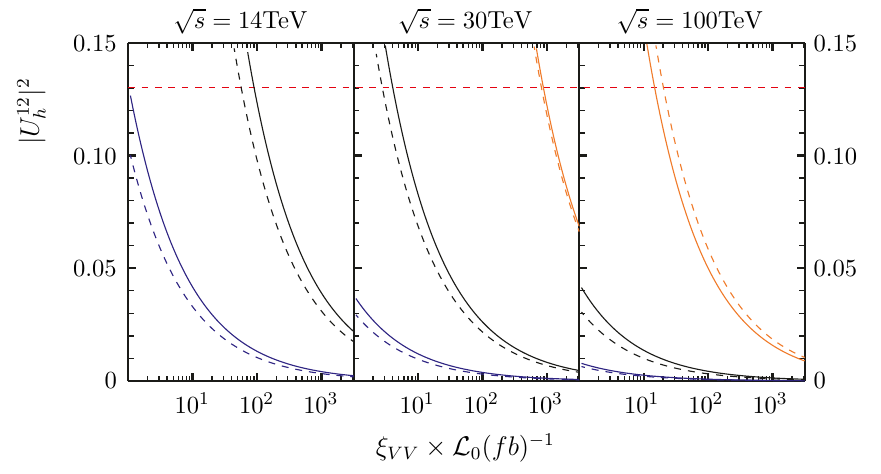
Figure 6 . The 5 σ limits of detecting a Triplet t 0 at the LHC. The curves are for t 0 decays into W + W − , and dashed ones are for t 0 (0 . 5 , 1 . 0 , 2 . 0) TeV, respectively. The horizontal dashed red line is the LHC-1 upper limit on